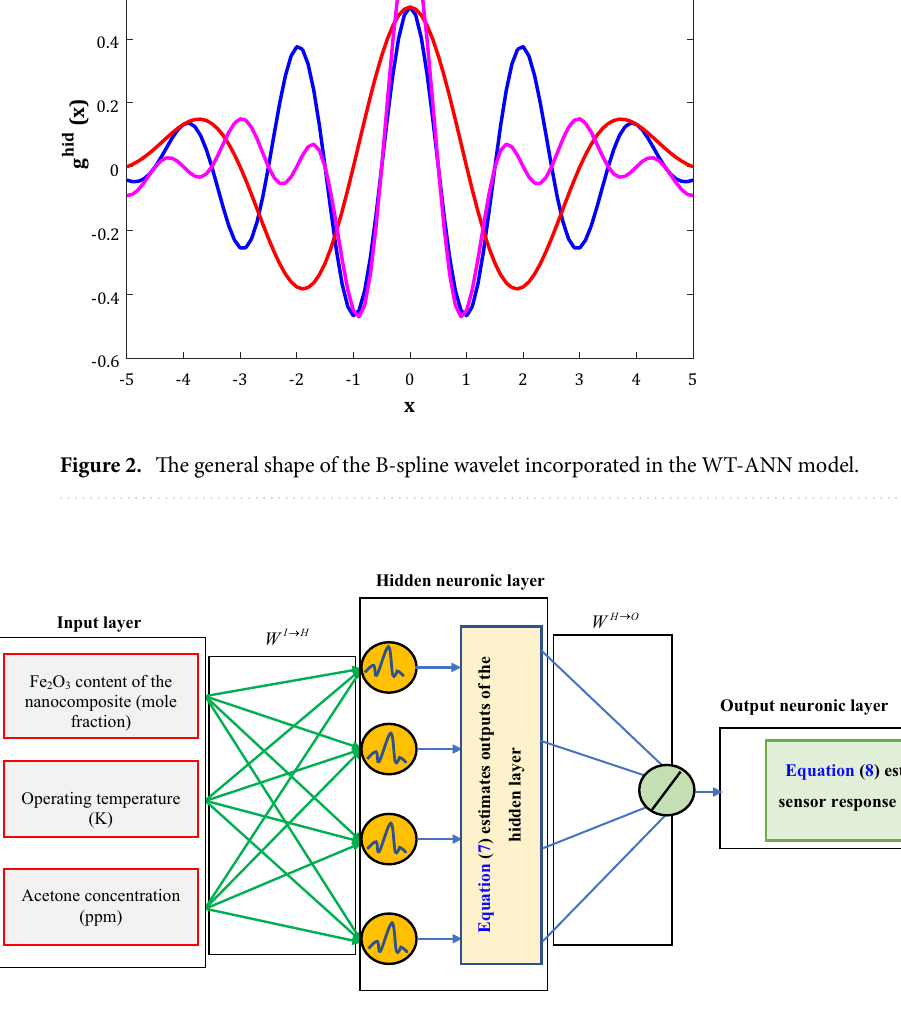
Figure 3. A typical WT-ANN with a 3-4-1 topology for estimating the acetone sensing ability of In 2 O 3 /Fe 2 O 3 nanocomposites 56